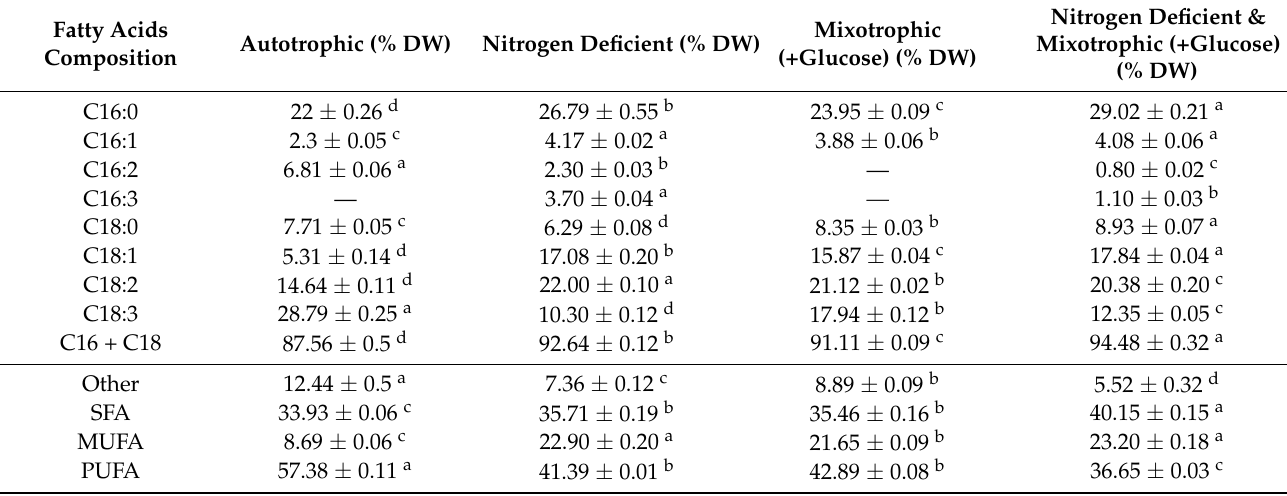
Table 3. Fatty acids composition of P. kessleri TY under different culture conditions. (Mean ± SEM, n = 3). Fatty